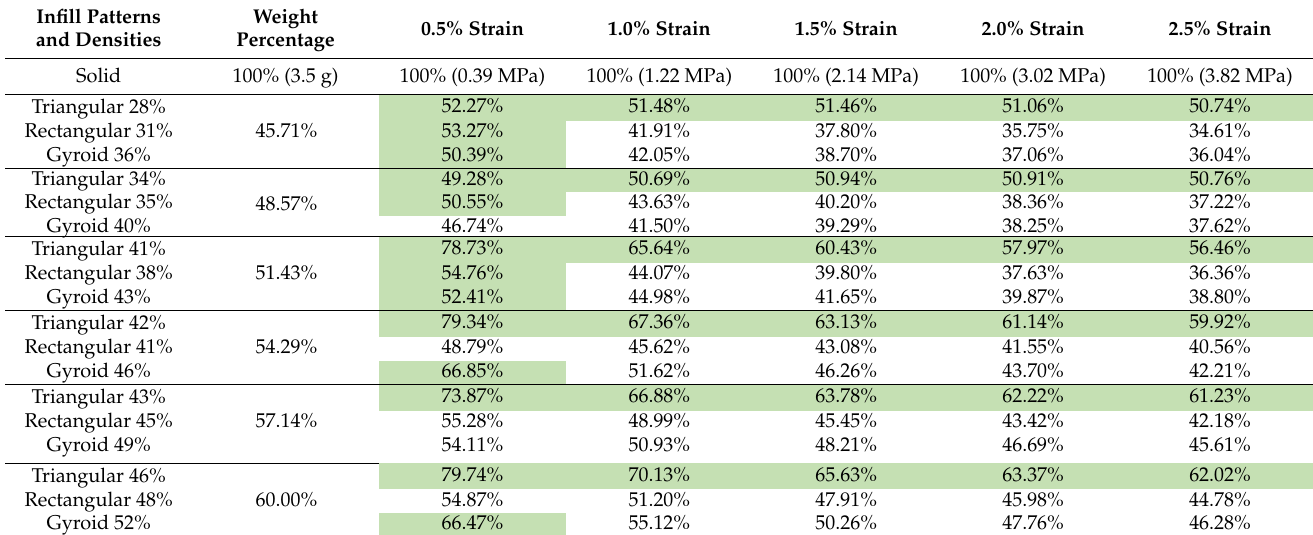
Table 4. Comparison of weight percentage versus compressive property percentage.